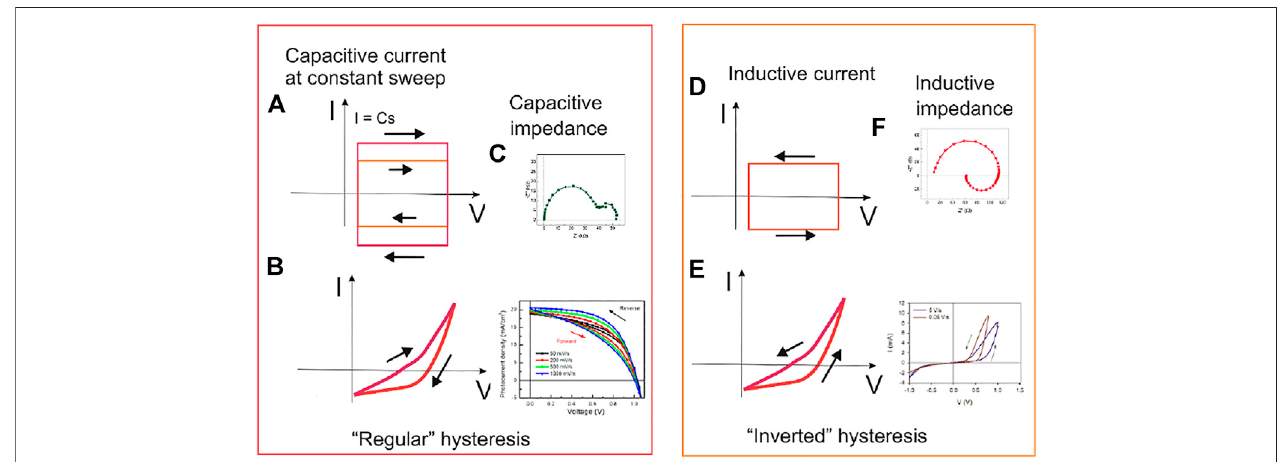
FIGURE1| Schematicresponseofimpedancespectroscopy,currentatconstantsweeprate V (cid:2) st ,andhysteresis,forcapacitiveandinductiveelements.Theleft panel shows the current of a constant capacitor (A) , a diode with the capacitive response (B) , and the impedance response (C) . In the right panel, the signs and directions of the currents are schematically described for a system that is inductive at low frequency. in terms of the current-voltage (D) , diode (E) and impedance (F)